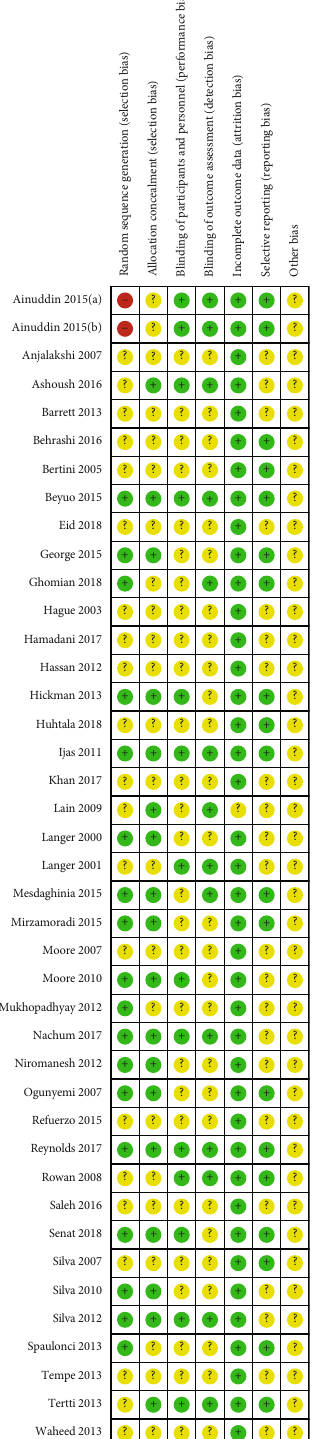
Figure 2: Risk of bias